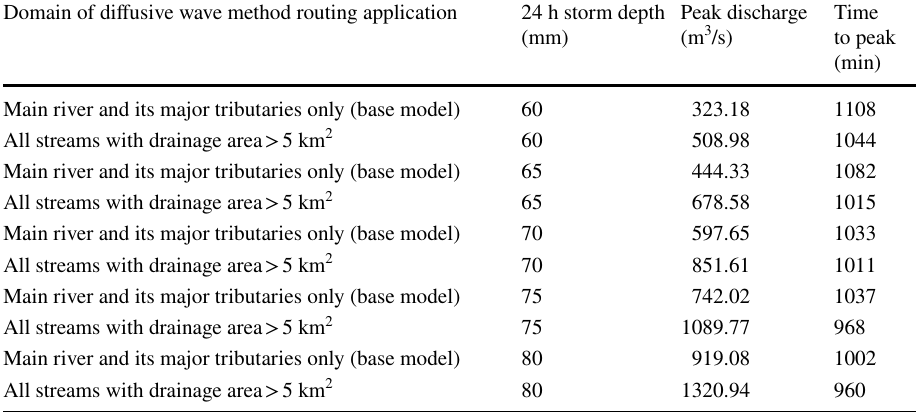
Domain of diffusive wave method routing